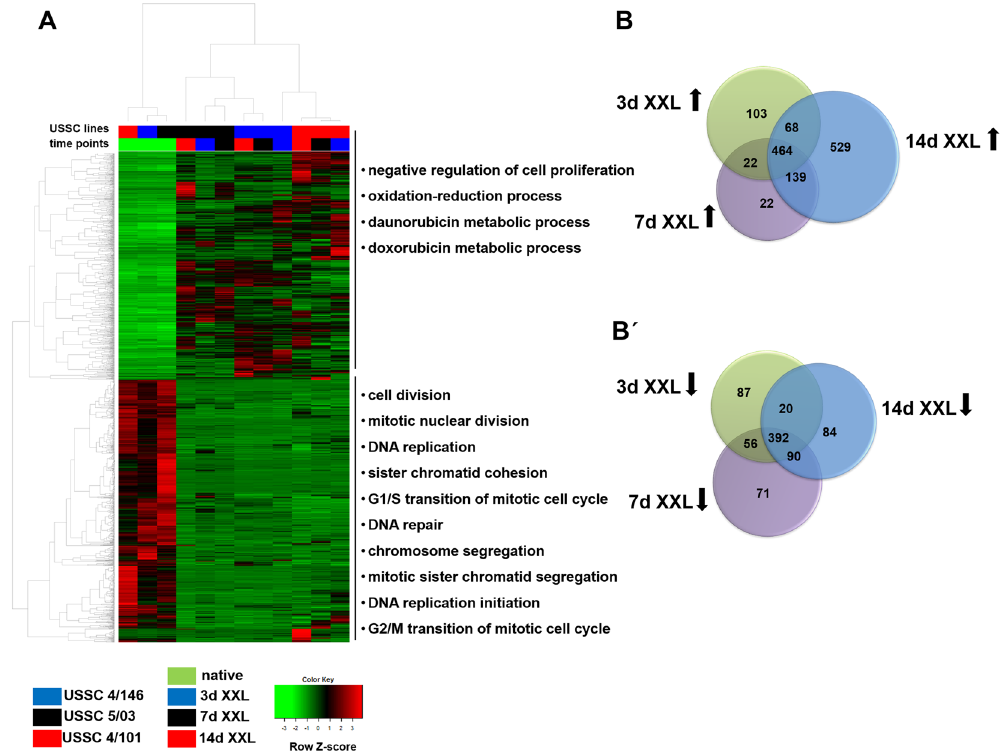
Figure 1. mRNA expression analysis of native and XXL-USSC. ( A ) Heat map of differentially expressed mRNAs in USSC lines 4/101, 4/146, and 5/03 (p < 0.01, q < 0.05, FC > 1.5) at time points native, 3d, 7d, 14d of XXL-incubation. USSC lines and time points are colour-coded at the top of the heat map. The heat map represents two main clusters of up- and downregulated mRNAs. Top categorical gene ontology enrichment annotations (q < 0.05) based on DAVID database are given for each cluster (top 10 are shown). ( B,B’ ) Venn diagrams of upregulated ( B ) and downregulated ( B’ ) mRNA at the respective time points of XXL incubation in comparison to native